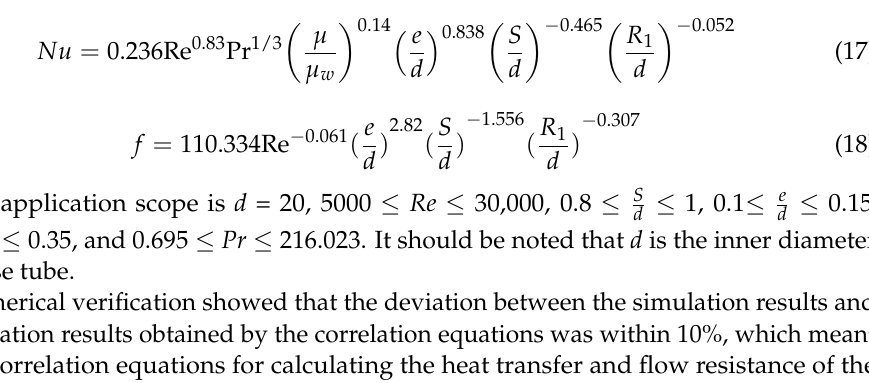
Figure 12. Variations in ( a ) Nu and ( b ) f with Reynolds number for HEHEs.